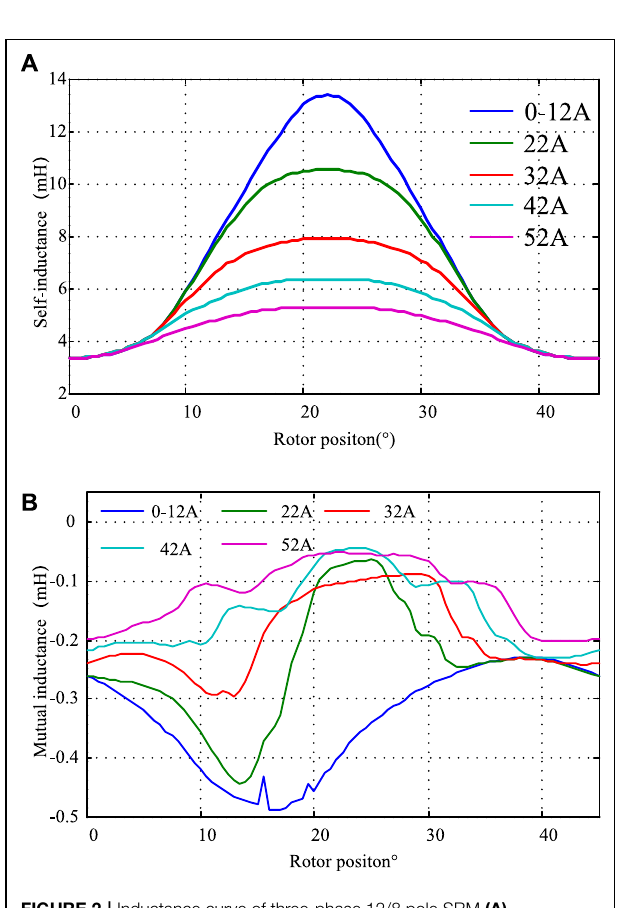
In the formula, ψ of A and B phases, respectively, and ψ inductance flux